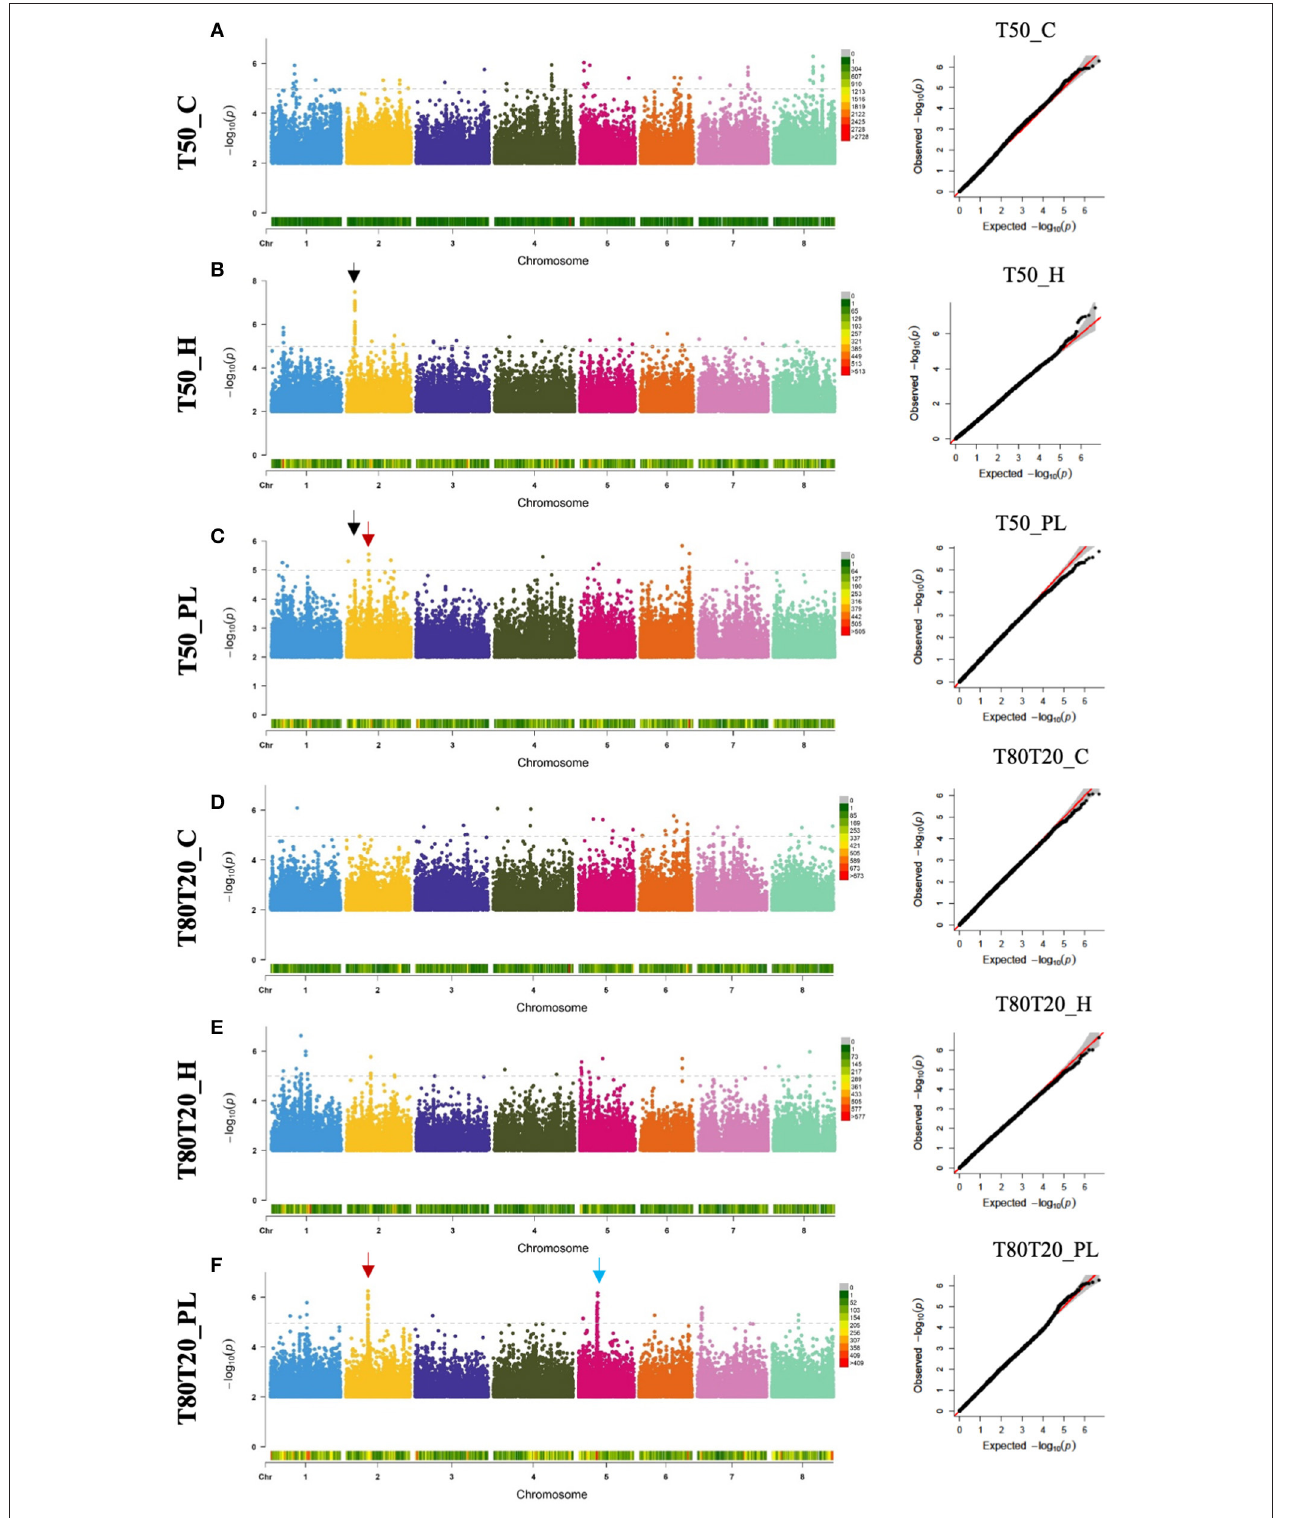
FIGURE 2 | Manhattan plots and the corresponding Q-Q plots from GWAS results regarding seed germination speed (T50) (A–C) and germination homogeneity (T80T20) (D–F) . Black arrows indicate the common QTN associated with both T50_H and T50_PL corresponding to the MtrunA17_Chr2g0286331 gene. Red arrows indicate the common QTN associated with both T50_PL and T80T20_PL corresponding to the MtrunA17_Chr2g0300261 gene. The Blue arrow indicates the highly significant QTNs located in chromosome 5. GWAS, genome-wide association analyses; QTN, quantitative trait nucleotides.